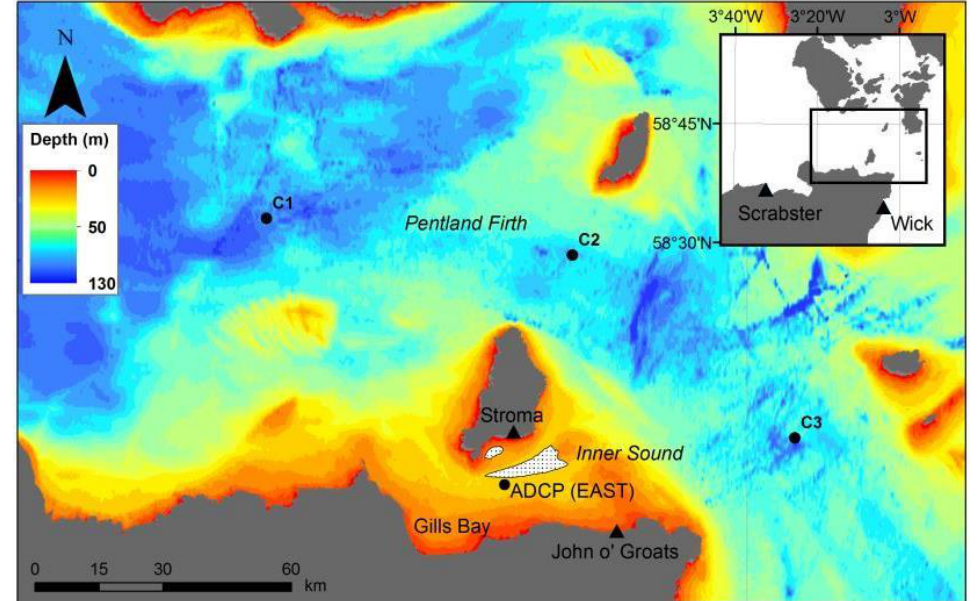
Figure 1. Instrument deployments in the Inner Sound, between the island of Stroma and Gills Bay on the Scottish mainland. Locations of Acoustic Doppler Current Profilers (ADCP) (●) and sea surface height (SSH) ( ▲ ) data are indicated. Water depths (m) are coloured. The positions of two sediment banks in the Inner Sound are indicated by the stippled areas.